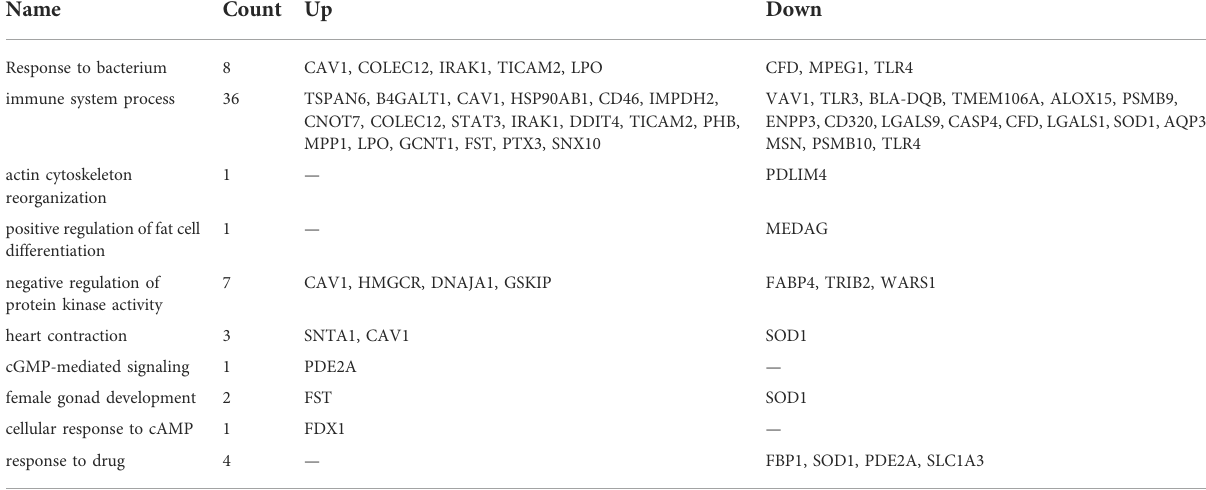
TABLE 2 The top ten most signi fi cant biological process ontologies for genes that were upregulated or downregulated in response to DEX.